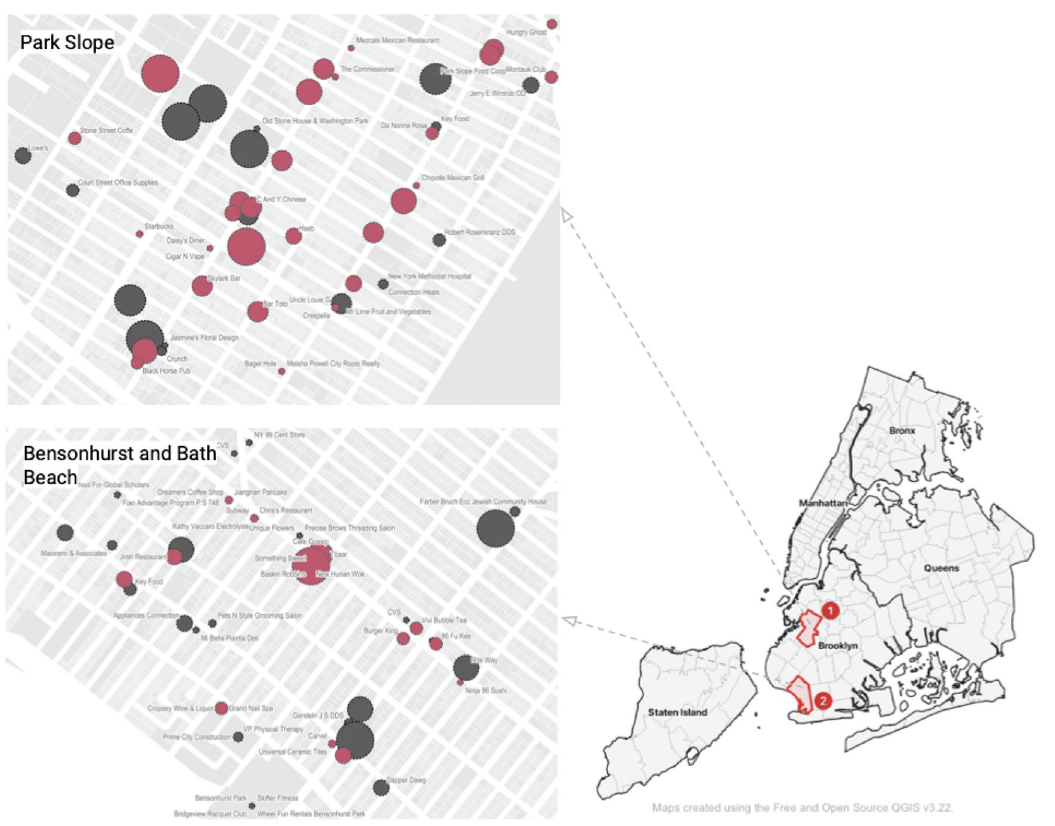
Figure 5. Case study: neighborhood comparison of sensitivity. Marker size represents relative sensitivity measurements. Left: Zip Code 11215, Park Slope area. Right: Zip Code 11214, Bensonhurst and Bath Beach area. Red markers represent food and drink places (e.g. restaurants, fast foods, cafes, or bars) and the grey markers represent other types of POIs.